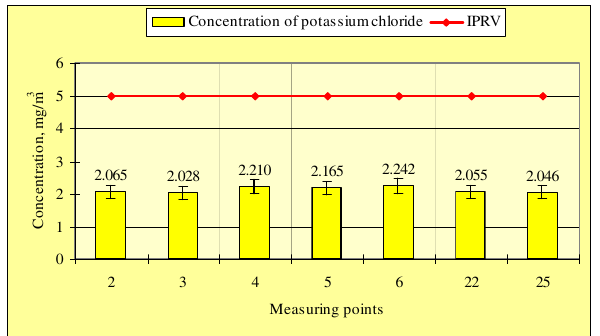
Fig 12 . Distribution of dust concentrations at Terminal of Powdery Manure Dischange in zone I